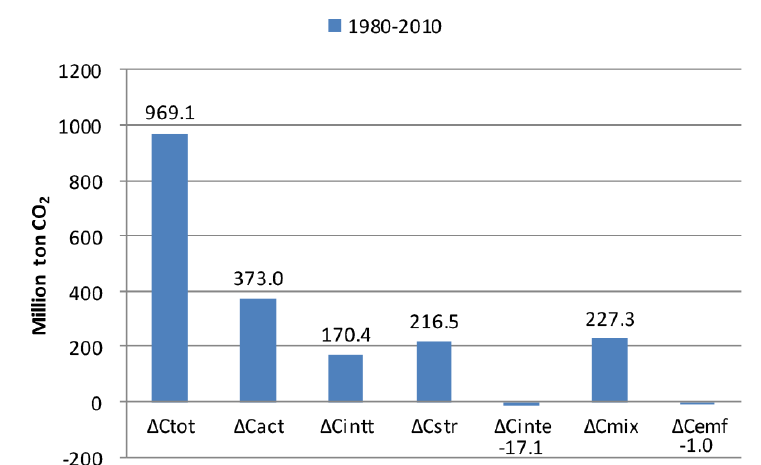
Figure 7. Bar chart for CO 2 emission decomposition in